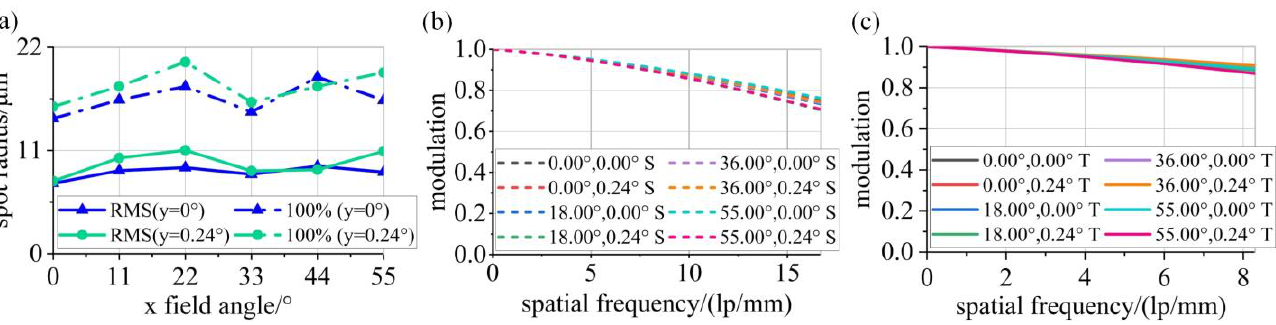
Figure 8. Performance analysis results of the UFOTAS: ( a ) spot diagram, ( b ) MTF in the X direction, ( c ) MTF in the Y direction.